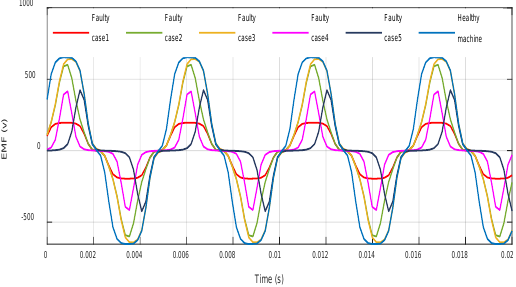
Figure 12. Electromotive forces (EMFs) of the PMSM with 75% uniform demagnetization under different cases.